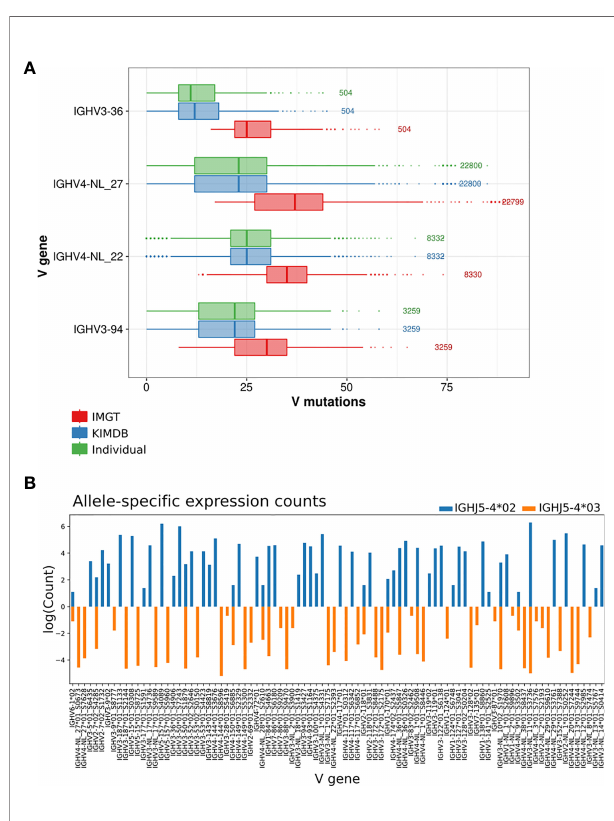
FIGURE 4 | Evaluation of V mutations from germline sequence using different germline gene databases and inferred haplotyping. (A) The average number of mutations in antibody sequences using four IGHV genes that are absent in the IMGT database after assignment to the animal ’ s individual IGHV database, KIMDB or the IMGT rhesus macaque database. The numbers to the right of each gene indicate the number of reads for that gene in the IgG library. (B) Inferred haplotype analysis of macaque D20. Illustration of inferred haplotyped allele content based on germline V allele VDJ recombination counts with heterozygous J alleles, IGHJ5- 4*02 (in blue) or IGHJ5-4*03